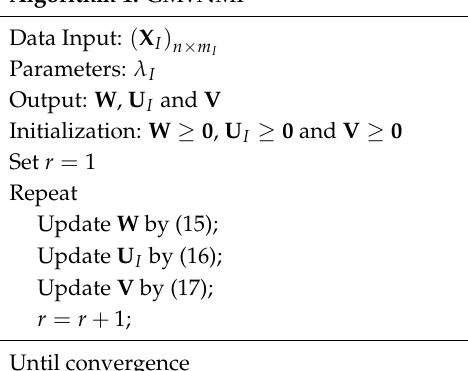
Algorithm 1: GMvNMF